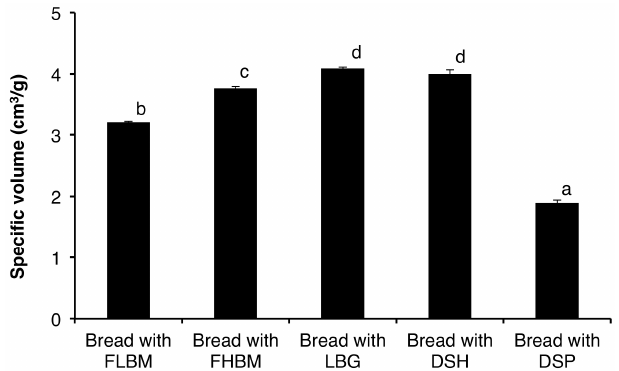
Figure 5. Specific volume (cm 3 / g) of bread prepared with FLBM, FHBM, FLBM supplemented with 0.75% LBG, FLBM supplemented with 0.75% DSH, and FLBM supplemented with 0.75% DSP. FLBM, flour of low bread ‐ making quality; FHBM, flour of high bread ‐ making quality; LBG, locust bean gum; DSH, date seed hemicellulose; DSP, date seed polysaccharides. The values not sharing the same letter (a–d) are significantly different ( p < 0.05).